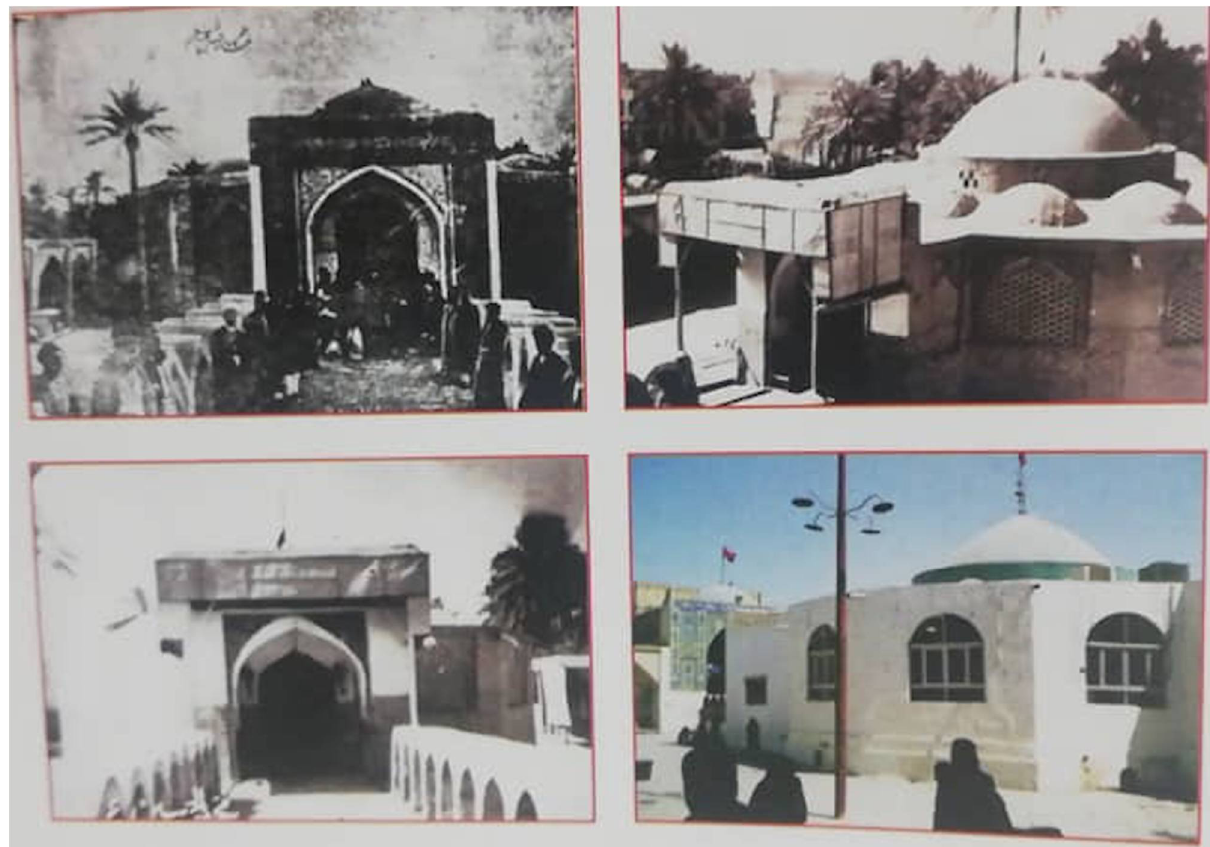
Figure 12. Former views of the Husayni encampment at Karbala. Source: Ahmad Alavi, Iraq: Rahnema-ye Safar-e Ziyarati [Iraq: Travel Guide] Ma’rouf: Qom, 2010).